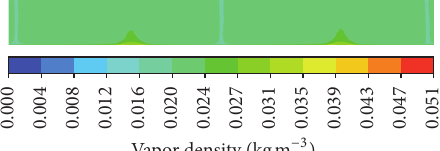
Figure 12: Local density of vapor below the middle jet at OP = 15%. Three jets are displayed in the